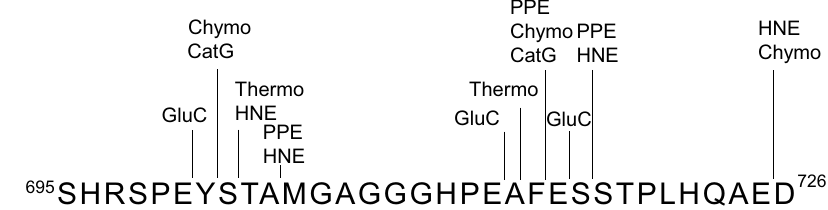
cleavage of A2ML1 by chymotrypsin and PPE but not trypsin, suggesting that chymotrypsin and PPE are inhibited by A2ML1, but not trypsin. N-terminal sequencing of the C-terminal frag- ment and LC-MS/MS analysis were performed to map the A2ML1 cleavage sites for plasmin, trypsin, thermolysin, chymo- trypsin, HNE, CatG, GluC, and PPE (Fig. 1E, F). All sequenced cleavage sites were located inside the predicted bait region of